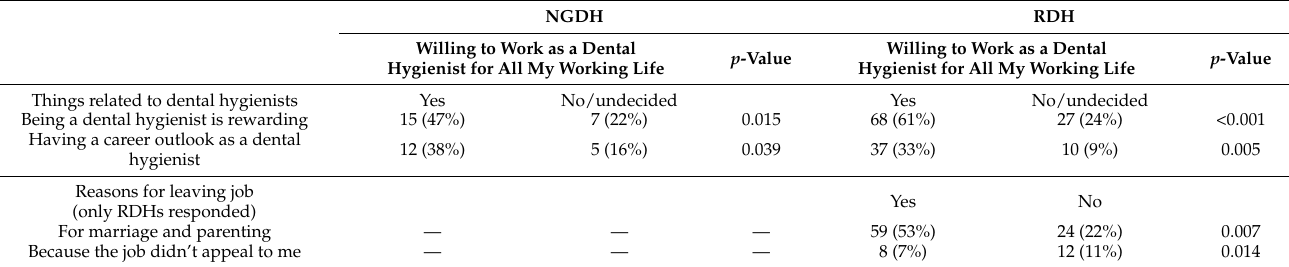
Table 2. Bivariate analysis of those who found being a dental hygienist to be rewarding, and career outlook and reasons for leaving against the presence of continued intention.